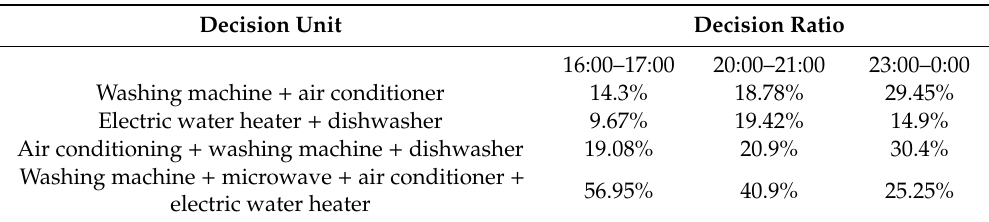
Table 5. Typical moment load side economic